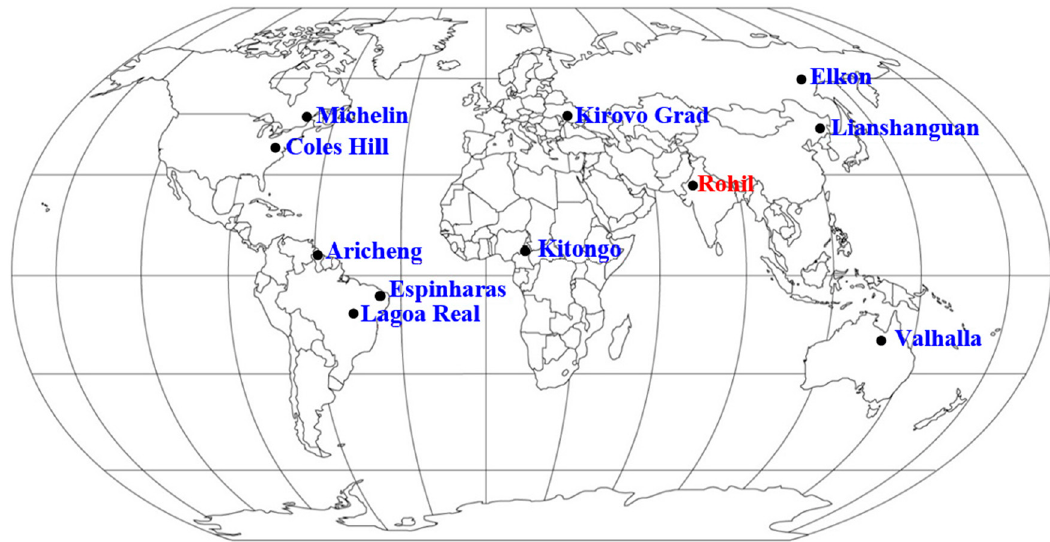
Figure 1. World map showing major metasomatite-type uranium deposits and the present study area (modified after